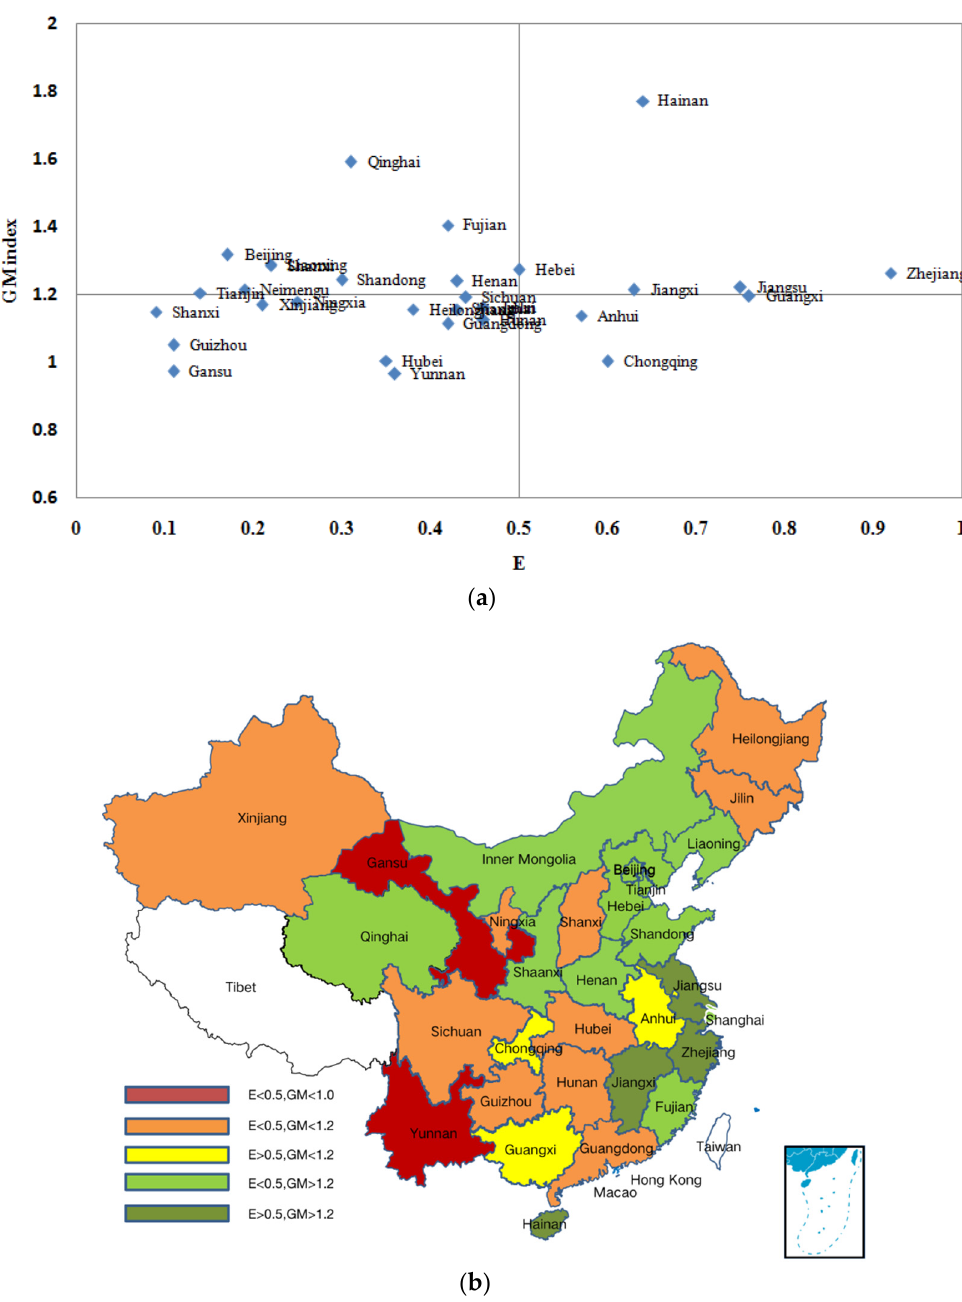
Figure 7. ( a ) Average system efficiency and system GM index from 2005 to 2010. ( b ) Average system efficiency and system GM index from 2005 to 2010.